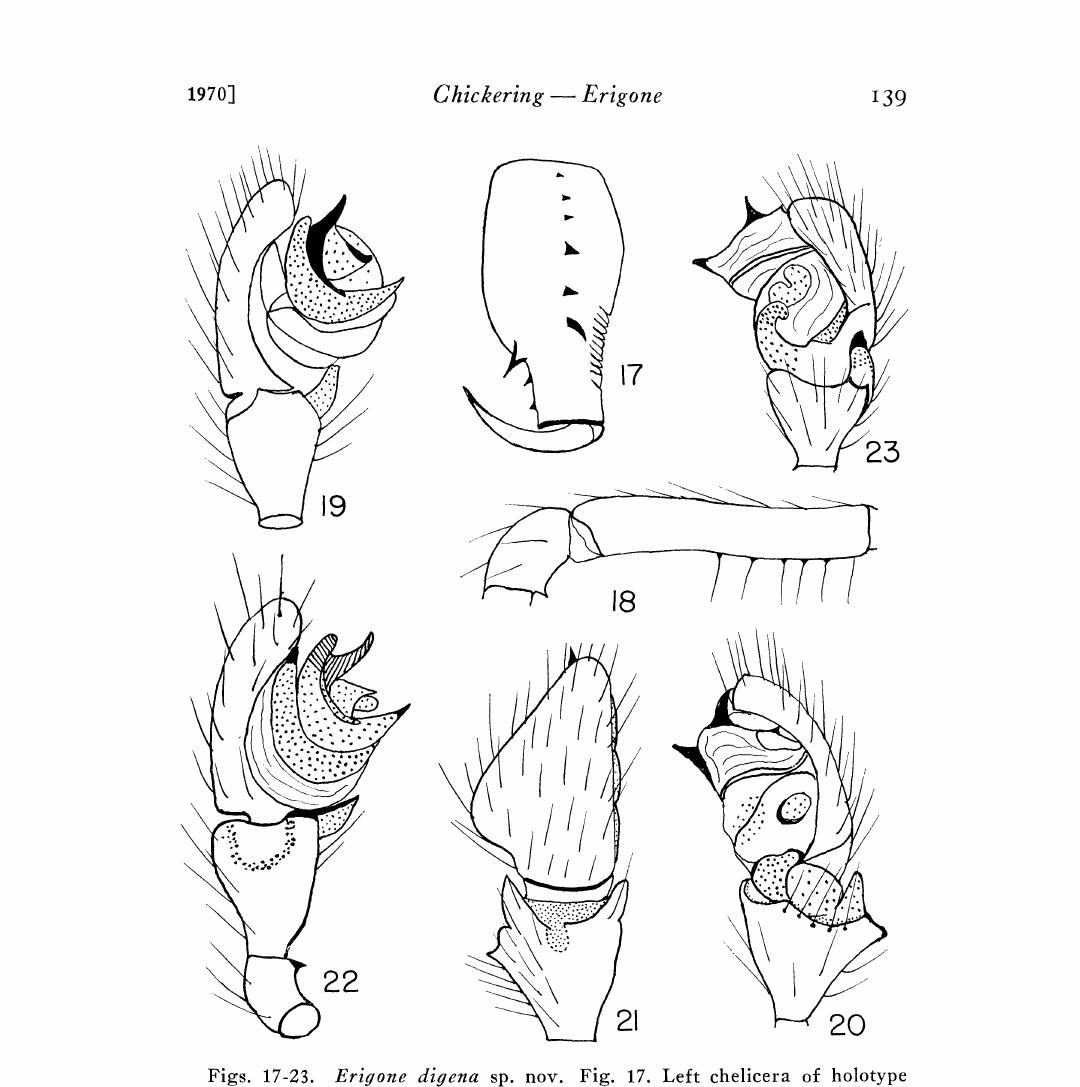
Fig. 19. Left palpal tibia and tarsus of holotype; prolateral view. Fig. 20. Idem; retrolateral view. Fig. 21. Idem; nearly dorsal view. Fig. 22. Palpal patella, tibia and tarsus of male from Jamaica, W. I.; prolateral view. Fig. 23. Palpal tibia and tarsus of male from Puerto Rico, W. I.; retrolateral